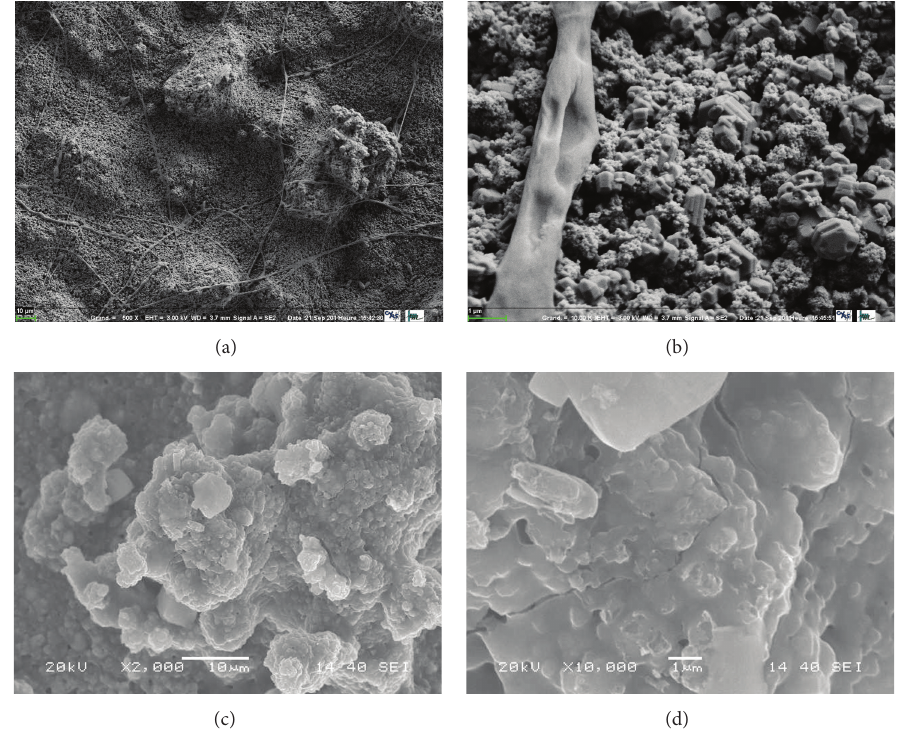
Figure 2: Effect of the number of layers on the stability of superhydrophobic coatings. (a, b) A single layer; (c, d) three layers.